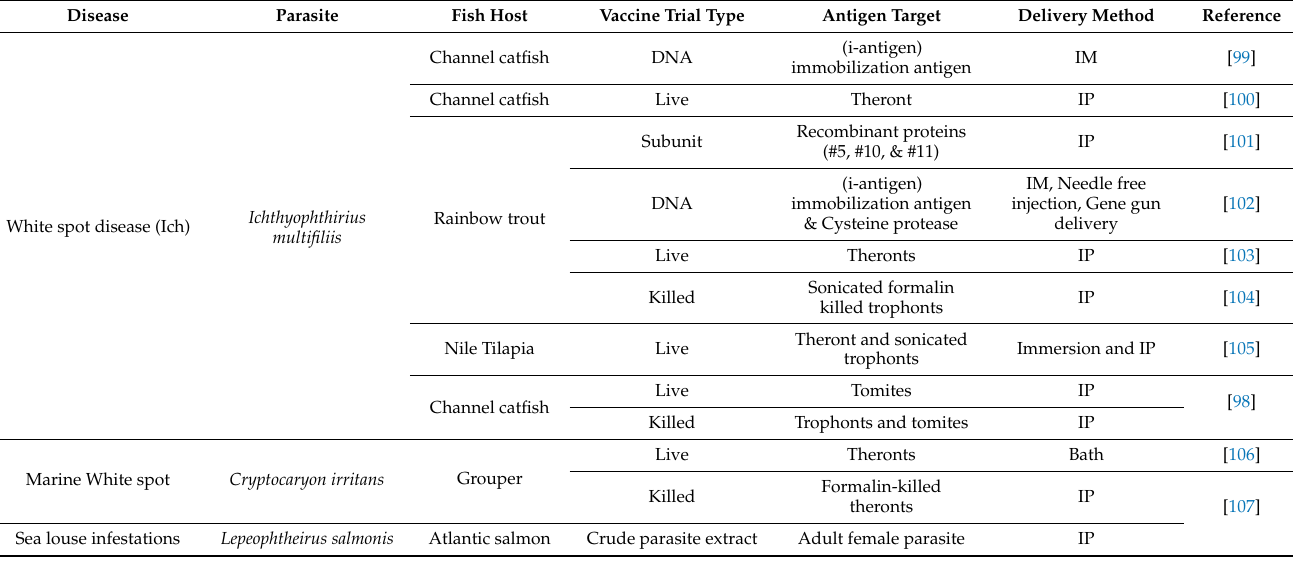
Table 2. Overview of immunization trials in fish for ectoparasites: Table provides information on immunization trials for important ectoparasites of fish. IM: Intramuscular, IP: Intraperitoneal.